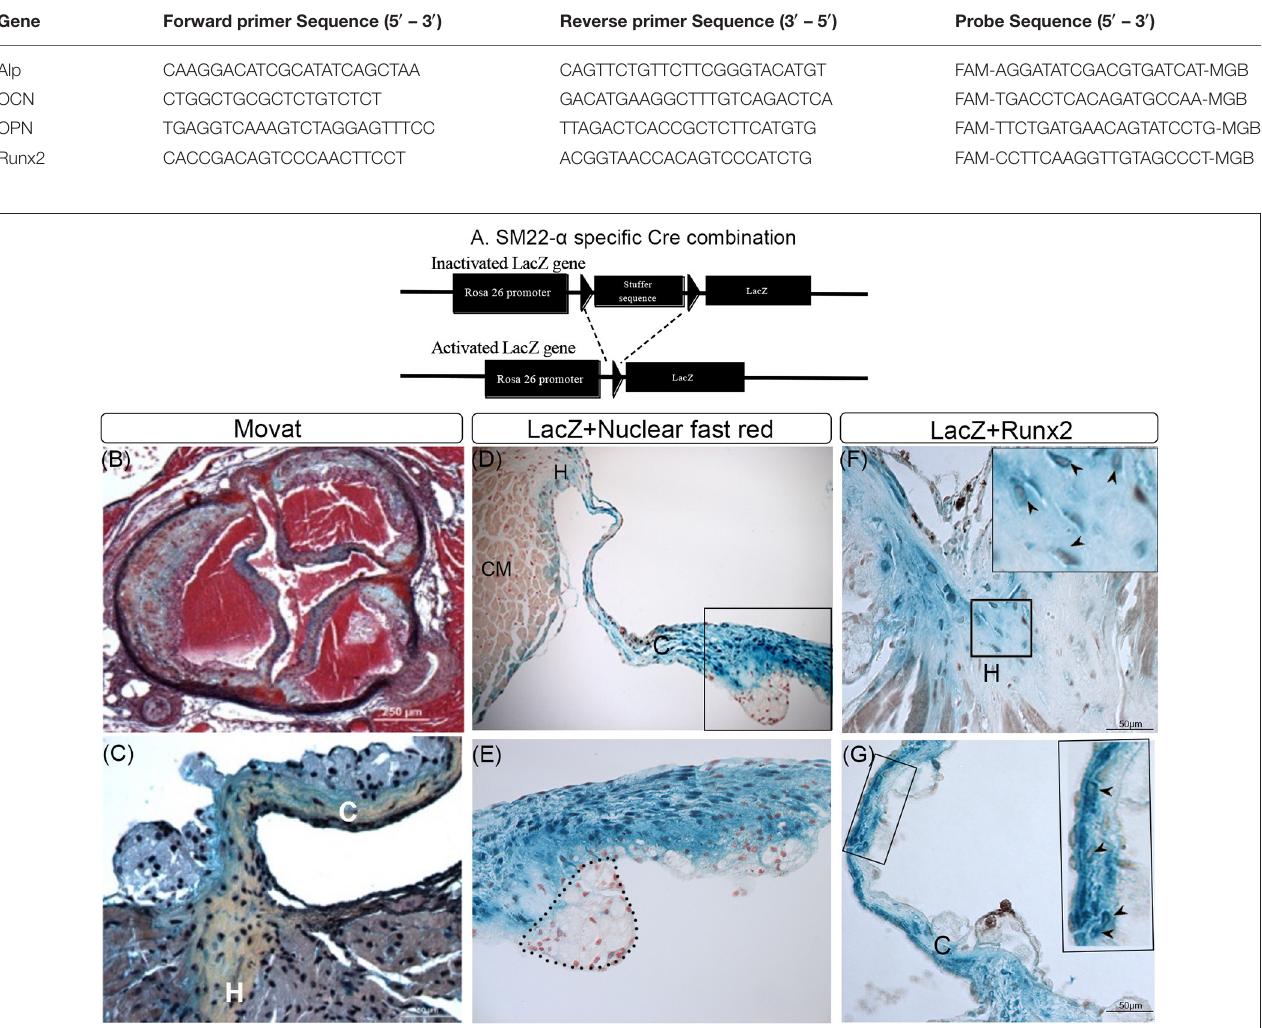
FIGURE 1 | Lineage tracing of runt-related transcription factor 2 (Runx2) + valvular interstitial cells (VICs) and sinus wall cells. (A) Schematic showing how Cre recombination leads to a permanent activation of the LacZ gene in SM22 α + VICs. (B–G) LDLr − / − : β -Gal SM22 mice were fed a diabetogenic (T2DM) diet for 28 weeks. Cartilaginous matrices (yellow collagen staining) in aortic valves were determined by Movat pentachrome staining (B,C) . VICs and sinus wall cells were stained blue with X-gal (D–G) . (D,E) Cell nuclei were counterstained with nuclear fast red. Note macrophage foam cells in the aortic side of the thickened valve leaflet that was not stained by X-gal (dashed line; D,E ). CM, cardiomyocyte cells (E) . Higher magnification (60x) image of boxed area in (D) . Immunohistochemical staining of X-gal stained (blue) hinge (F) and cusps (G) of the aortic valve for Runx2 (brown, arrowheads). Inset in (F,G) are enlarged images of the boxed area. C, Cusp; H,